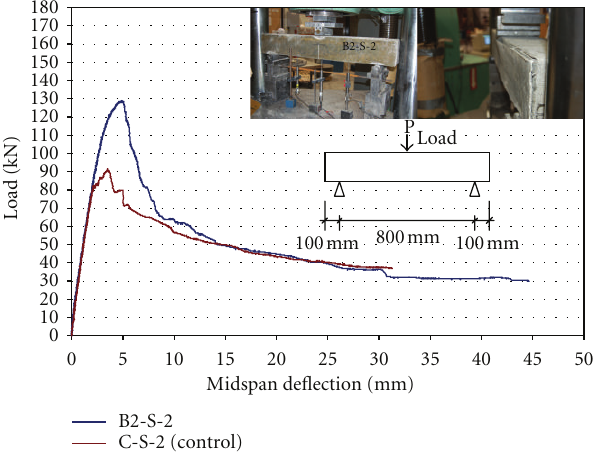
Figure 19: Load versus midspan deflection of RC beam B2-S-4.